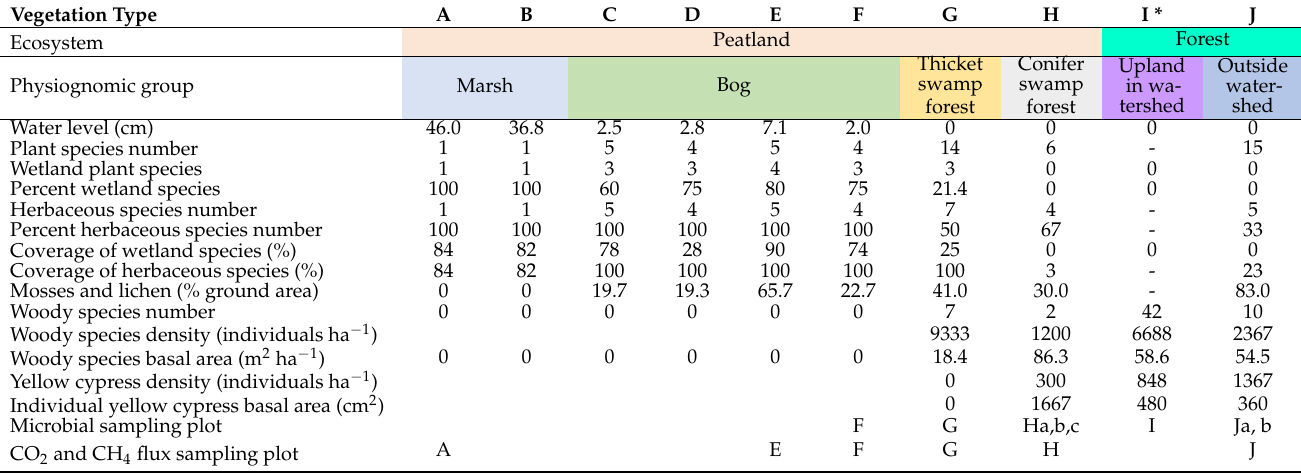
Table 1. Vegetation composition variables of the 10 vegetation types in the Yuanyang Lake (YYL) Nature Reserve and nearby